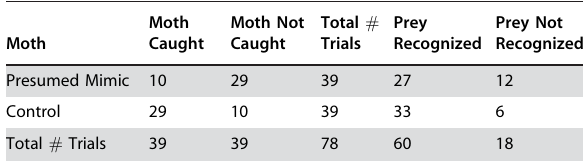
Table 1. Results of trials with the jumping spider Phiale